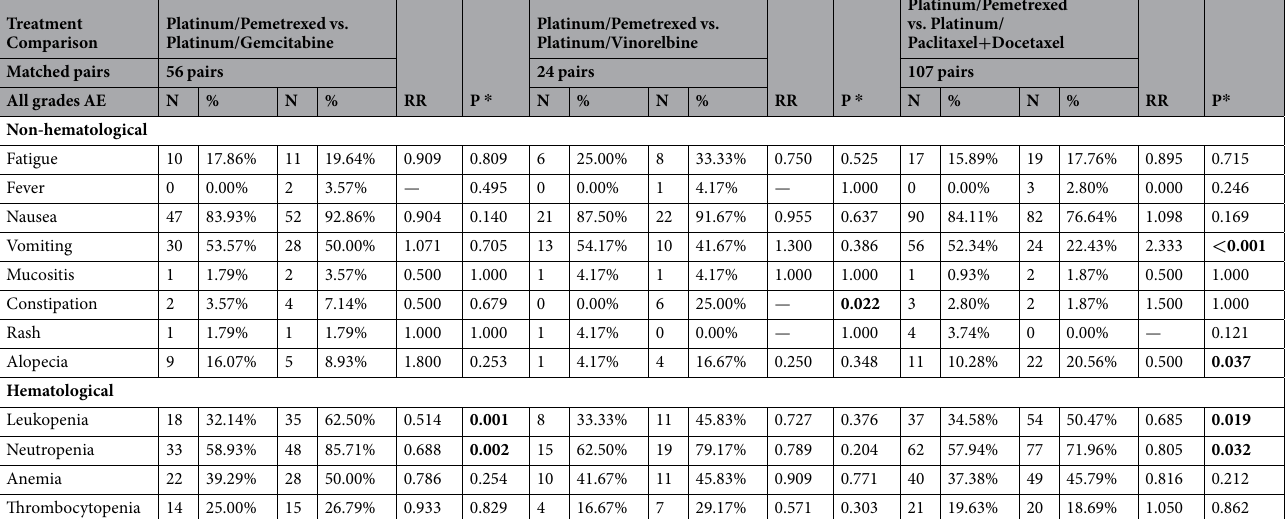
Table 3. Comparing incidences of hematological and non-hematological AEs between the propensity score matched treatment group. AE, adverse event; RR, rate ratio. * P values less than 0.05 were in bold to indicate significant differences.